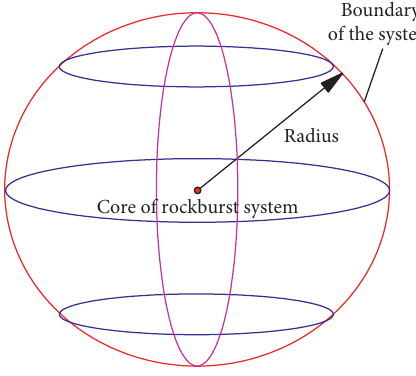
Figure 1: Schematic diagram of “spherical” type rock burst system.